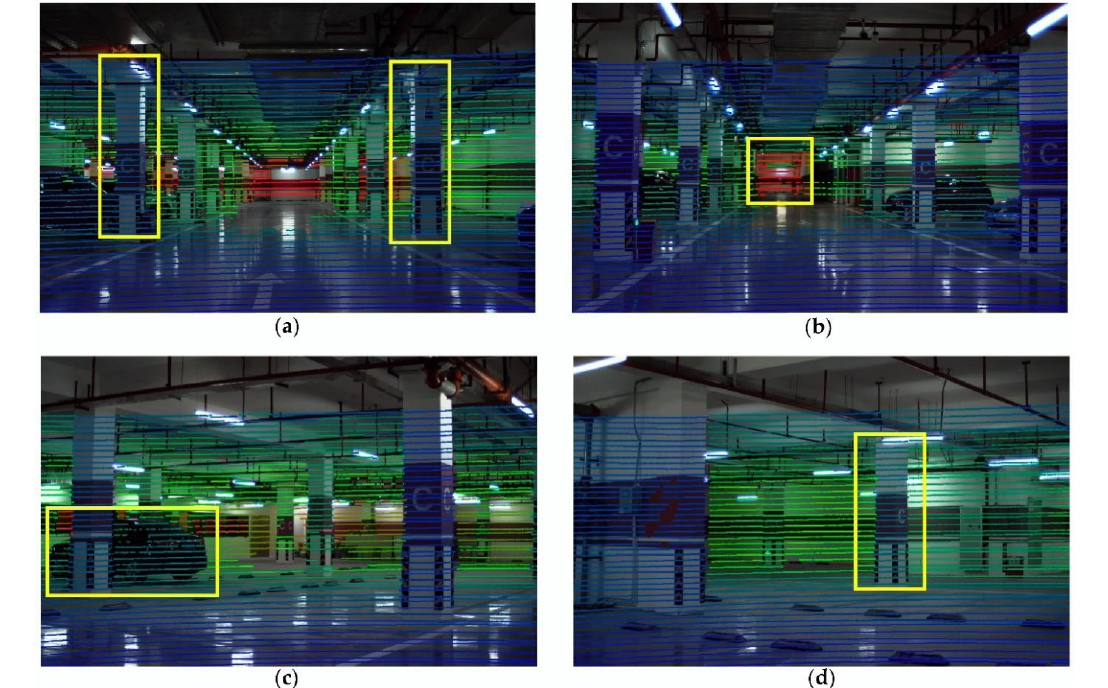
Figure 14. Results of outdoor scene test, 𝜃 = 0.1°. The contents in yellow rectangles in ( a - d ) are projections at different distances.